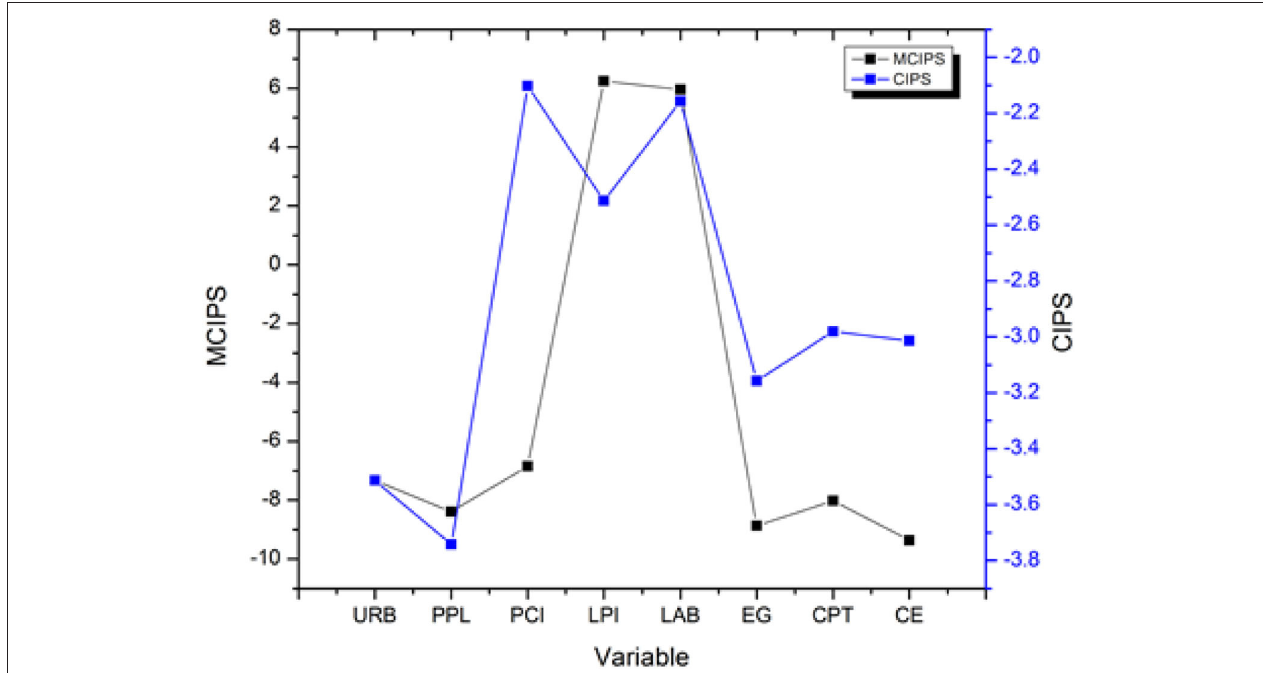
FIGURE 2 | Results of unit root test (Level 0); Pesaran (49).